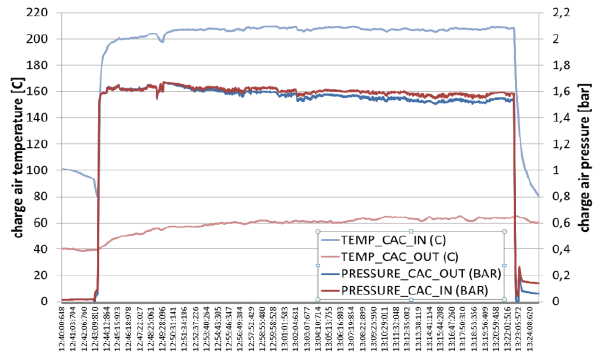
Fig. 5. Temperature and pressure of engine charge air measured before and after the air cooler